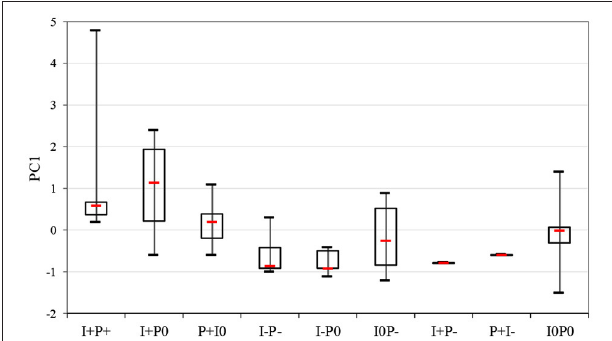
FIGURE 4 | Boxplot of PC1 anomaly of TP snowfall in case of IOD and ENSO combinations. Red shorts line denote the median, black short lines are minimum and maximum value, the top and bottom of the box are the 25th and 75th percentile,